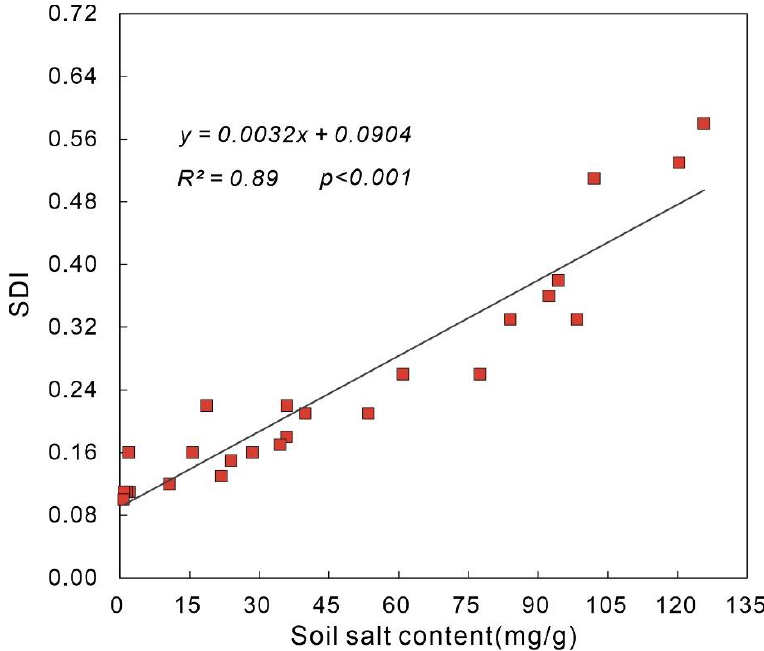
Figure 12. Relationship between the SDI and field-measured soil salt content.